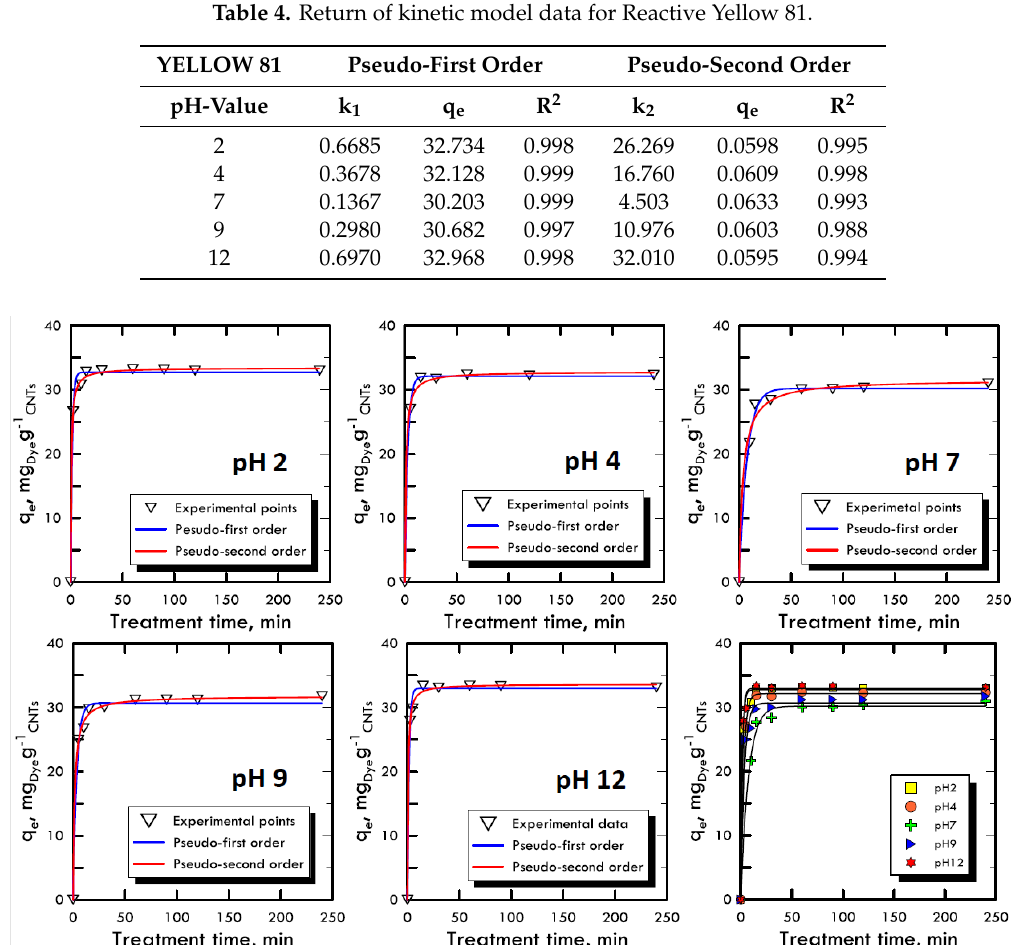
Figure 5. Kinetic adsorption model for Reactive Yellow 81 at different pH values. Table 4. Return of kinetic model data for Reactive Yellow 81.